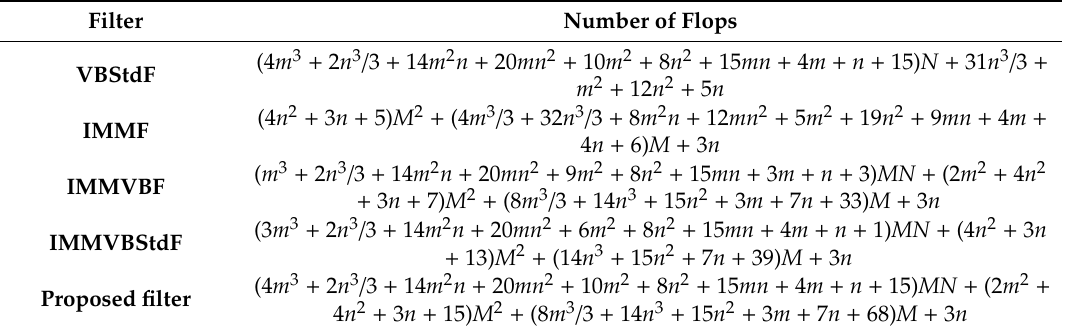
Table 2. Computational complexity of filters, where m denotes the dimension of measurements, n denotes the dimension of target state, M denotes the number of models for interacting multiple model type filters, and N denotes the number of fixed point iterations for variational Bayesian approach based filters.